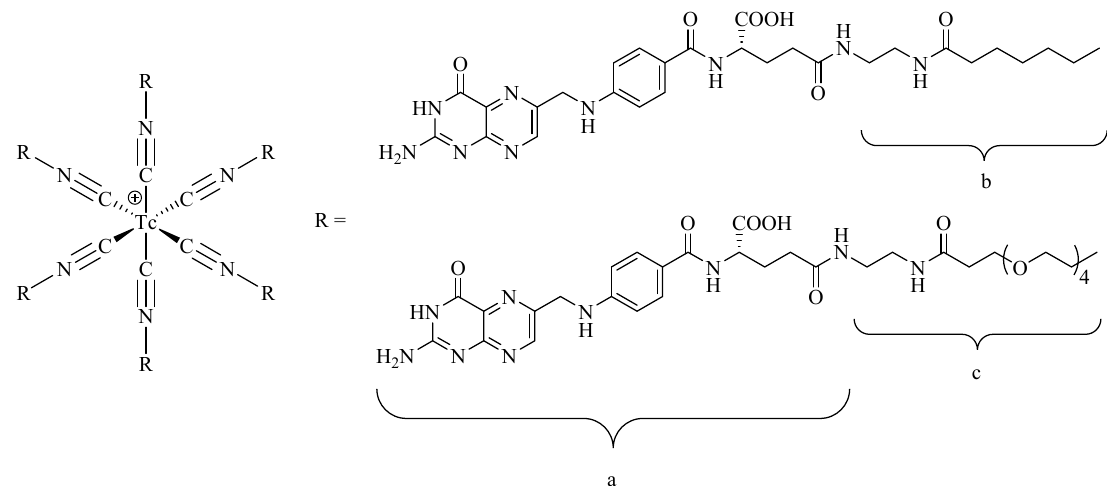
Scheme 2. The proposed structures of the radiolabeled tracers of [ 99m Tc]Tc-CN5FA and [ 99m Tc]Tc-CNPFA (“a” stands for target group, “b” and “c” stand for linkers, “–CN” stands for BFC, technetium-99m as a nuclide).